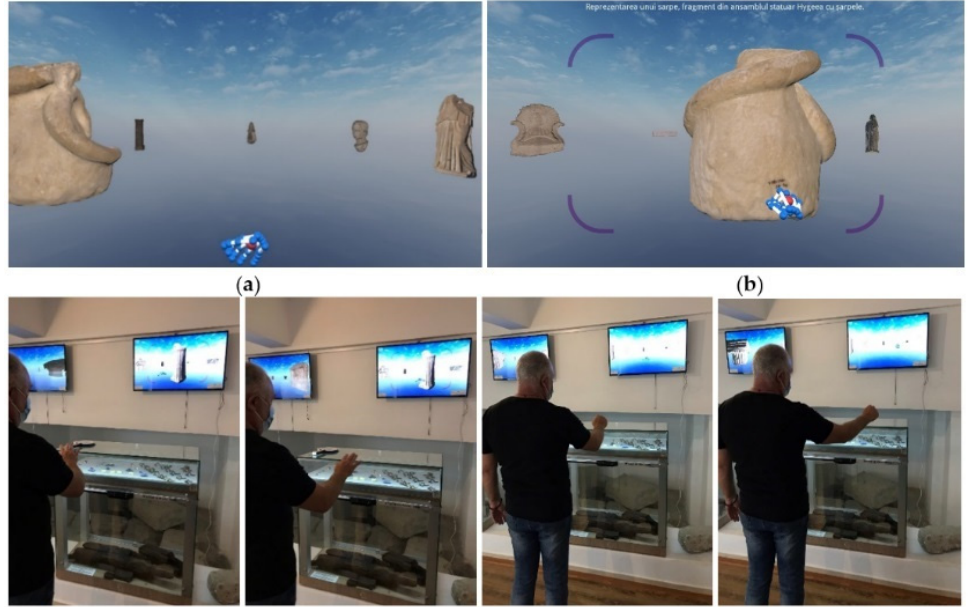
Figure 8. Visualization and interaction with entire 3D scene ( a ) and a virtual artifact ( b ). Courtesy of Popovici et al. [83].